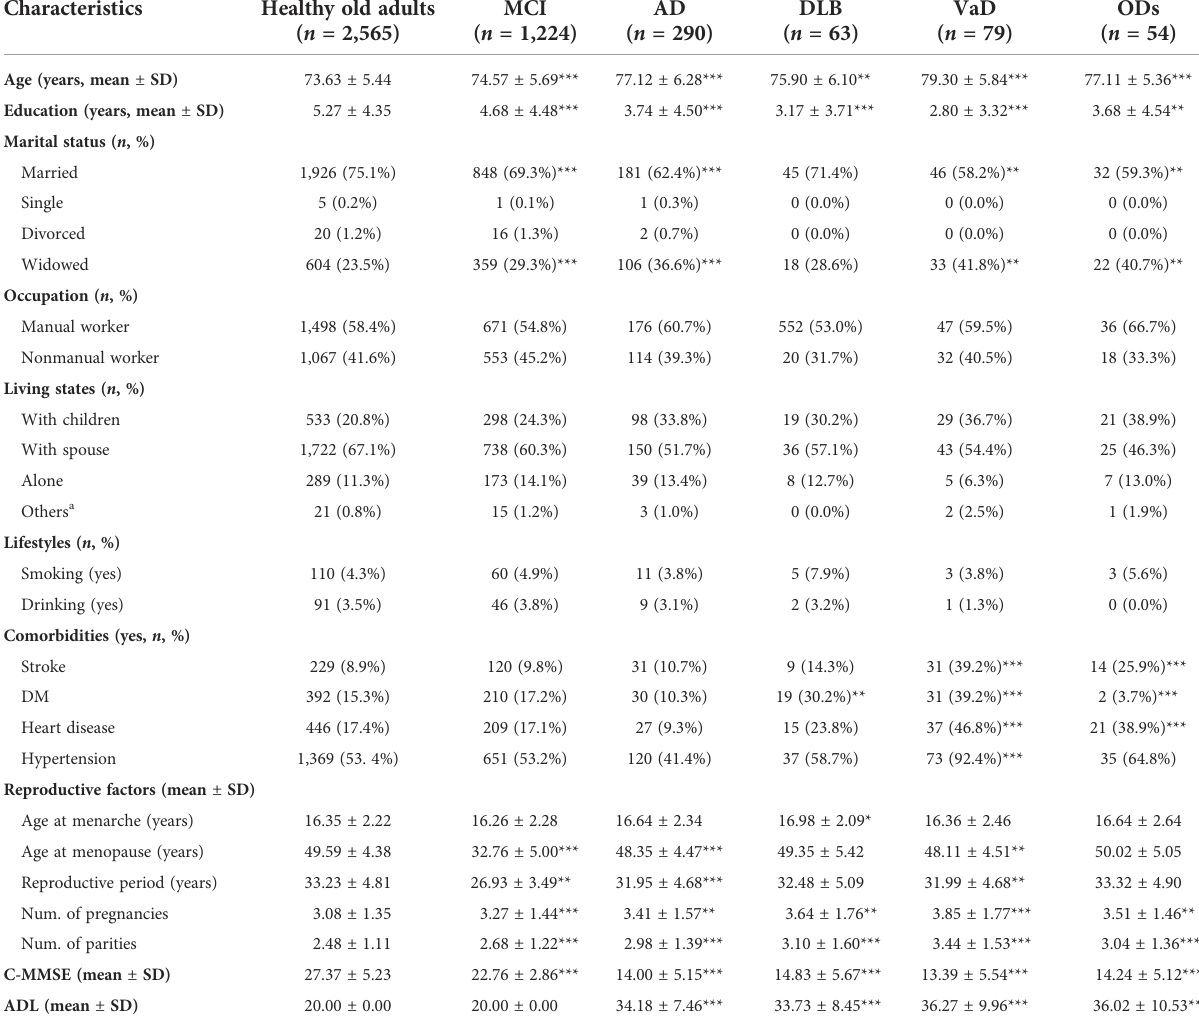
TABLE 2 General characteristics of participants by diagnosis.